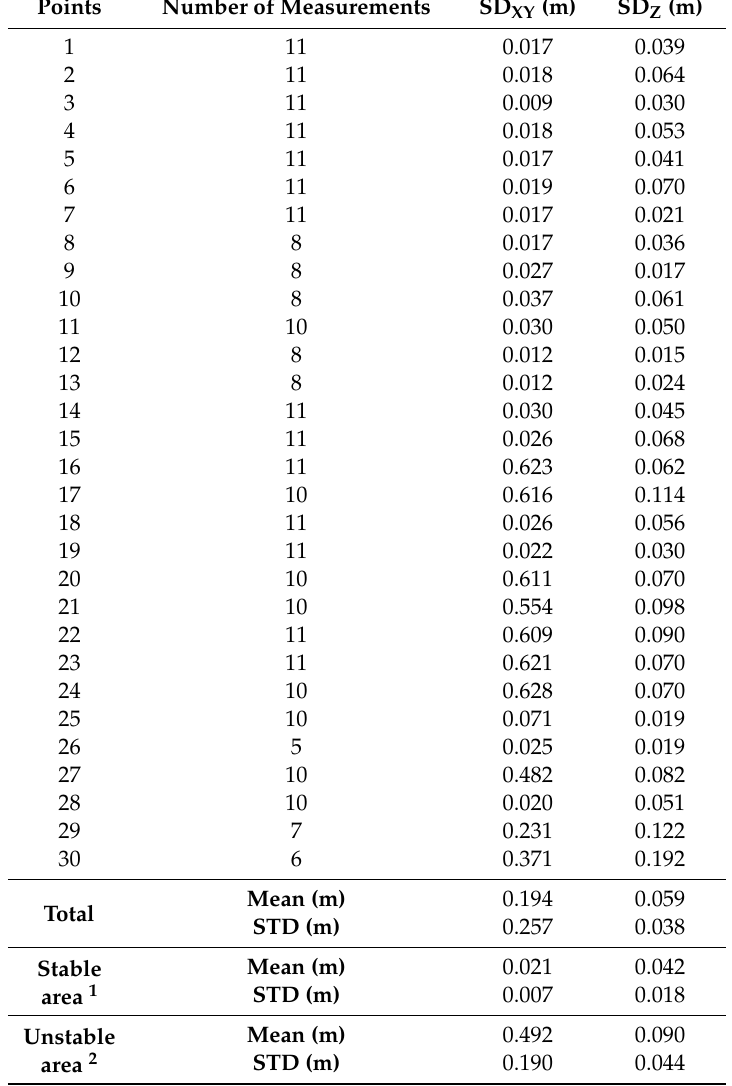
Table 3. Standard deviations of the monitoring points coordinates along the di ff erent epochs. Points Number of Measurements SD XY